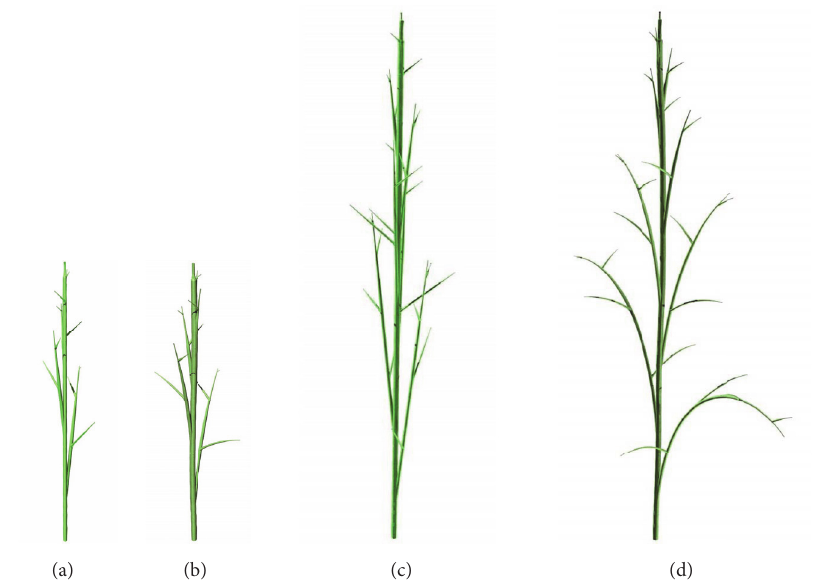
Figure 8: Comparing modeling effect with gravity or not. (a) Day 50 without gravity. (b) Day 50 with gravity influence. (c) Day 80 without gravity. (d) Day 80 with gravity influence.